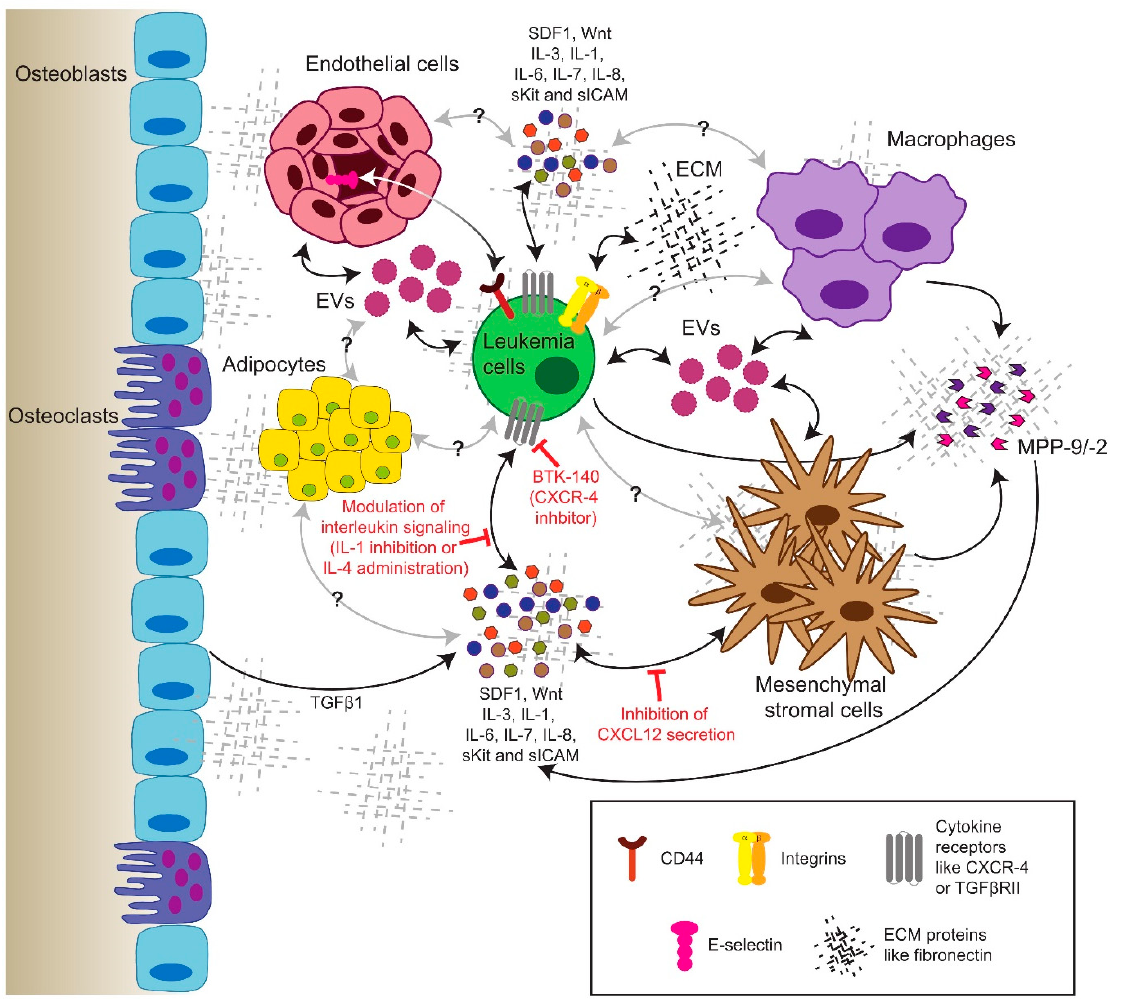
Figure 2. Schematic delineating the anatomy of the bone marrow microenvironment of CML (stem) cells, as well as their interactions with different niche cell types, secreted factors (whose variety is represented by different shapes and colors) and components of the extracellular matrix. Different strategies for targeting these interactions between CML stem cells and their microenvironment in combination therapies are presented in red. The black arrows represent interactions which are known, while the gray arrows represent possible interactions which have not yet been described. EVs = extracellular vesicles; SDF-1 = stromal-derived factor 1 (= C-X-C motif chemokine 12 (CXCL12)); IL = interleukin; ECM = extracellular matrix; sKit = soluble Kit; sICAM = soluble intercellular adhesion molecule; MMP-2/9 = matrix metalloproteinase-2/-9; TGF β 1 = transforming growth factor β 1; TGF β RII = transforming growth factor receptor II; CXCR-4 = C-X-C chemokine receptor type 4.